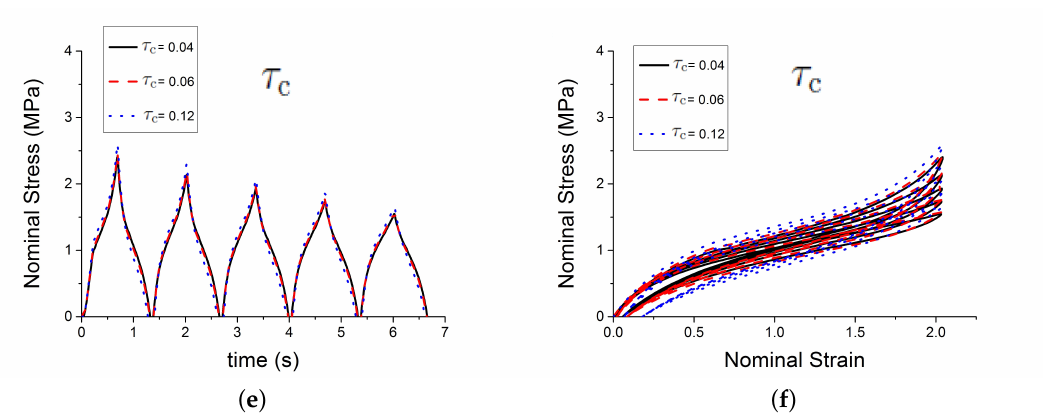
Figure 6. Influence of parameters. ( a , b ) show the effect of the parameter c 2 ; ( c , d ) show the effect of the parameter n ; and, ( e , f ) show the effect of the parameter τ c .